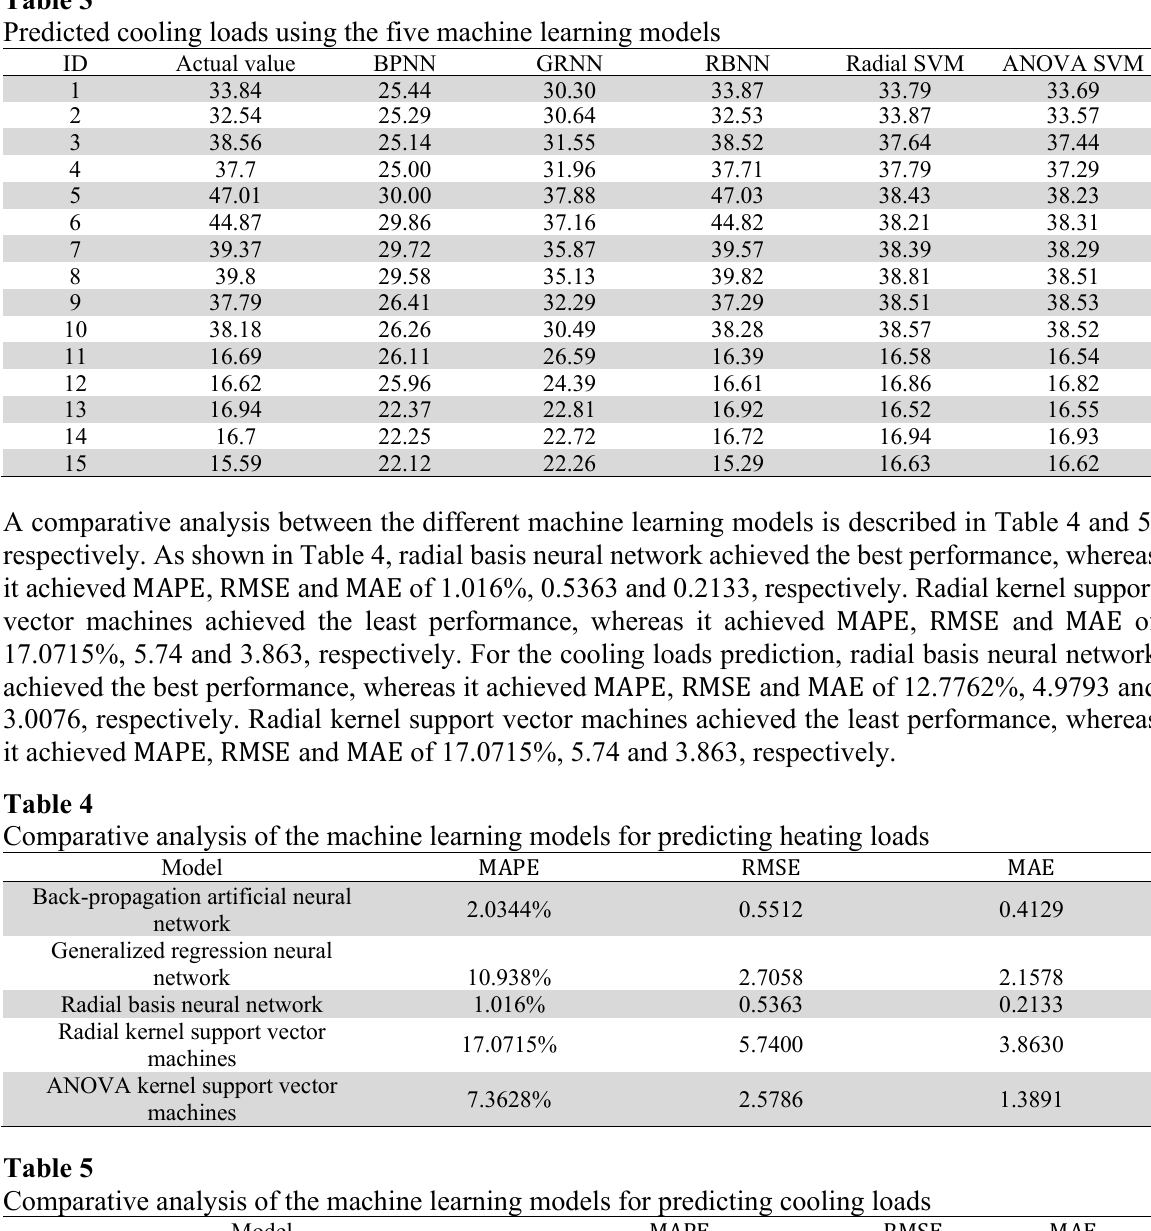
Comparative analysis of the machine learning models for predicting cooling loads Model MAPE